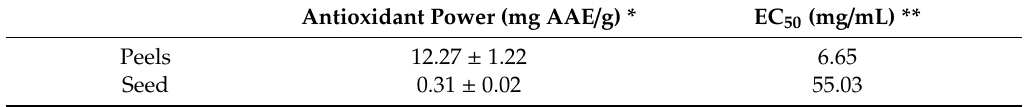
Table 1. Antioxidants content and activity in cantaloupe peels and